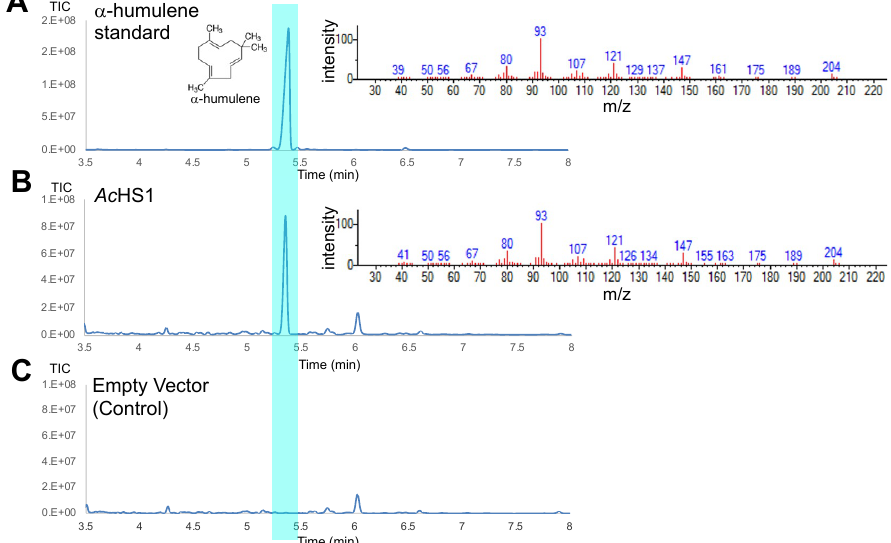
Figure 4. Total ion chromatograms (left panel) and mass spectra (right panel) obtained from GC-MS analysis of an authentic standard for α -humulene ( A ) and dodecane samples from the cultivation of strains FPPY005_39850 harboring pRSII426-Gal1/10-AcHS1 ( B ) and FPPY005_39850 harboring the empty vector pRSII426-Gal1/10 ( C